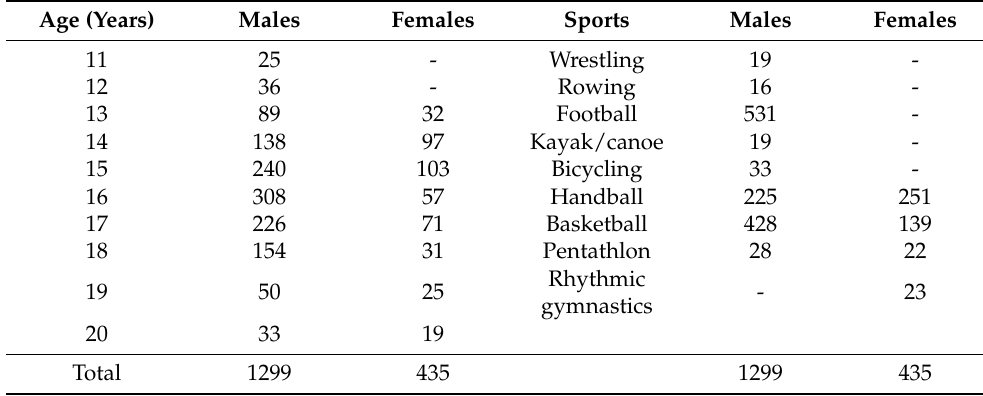
Table 1. Distribution of young athletes by gender within age groups and sports.